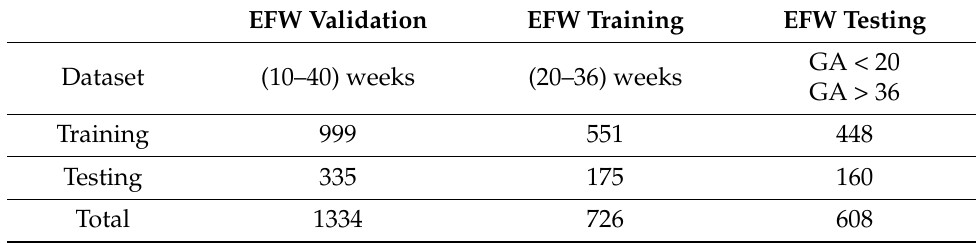
Table 5. Estimated fetal weight dataset.